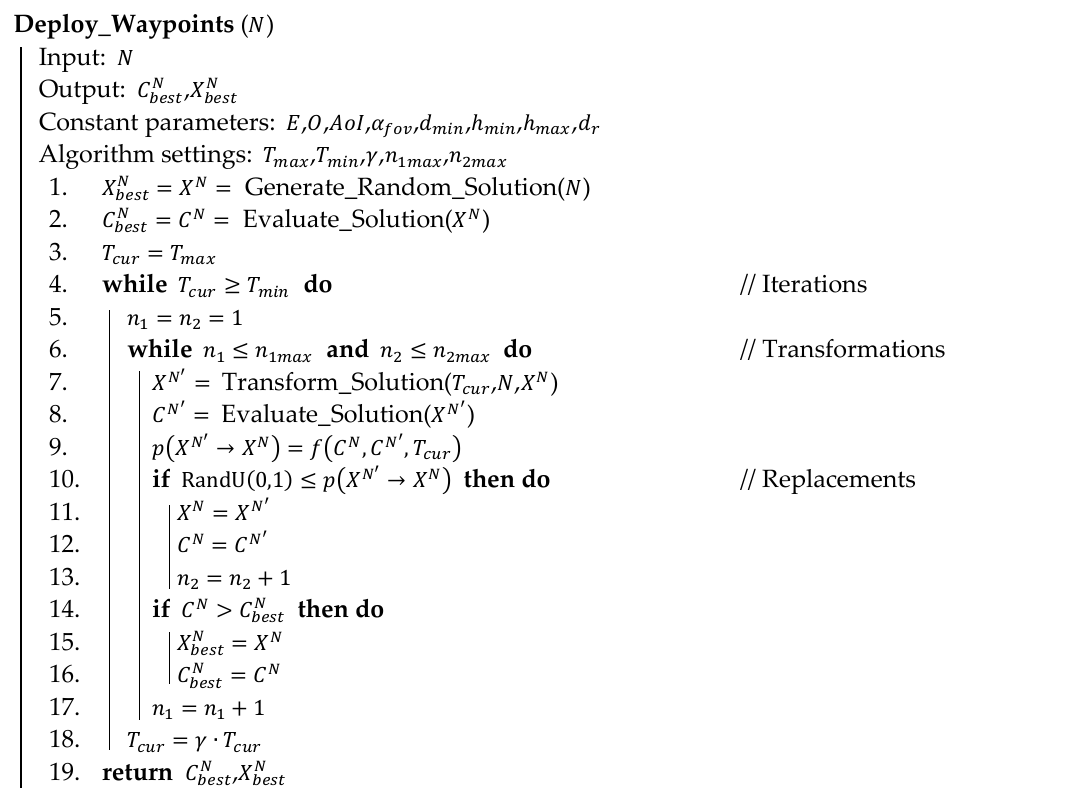
Algorithm 3 Optimization of waypoint deployment in pseudocode